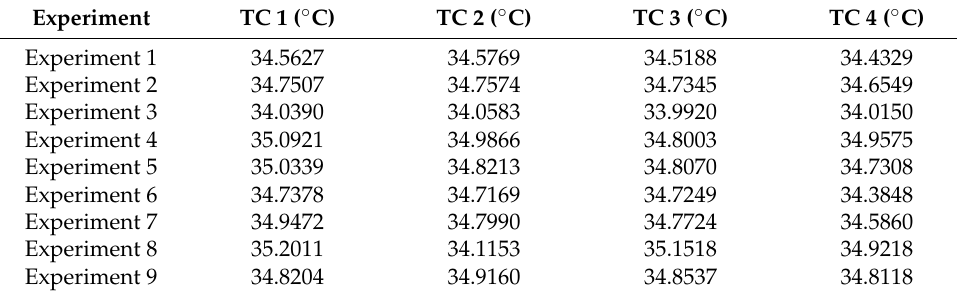
Table 4. Temperature result for each TC based on all DOE